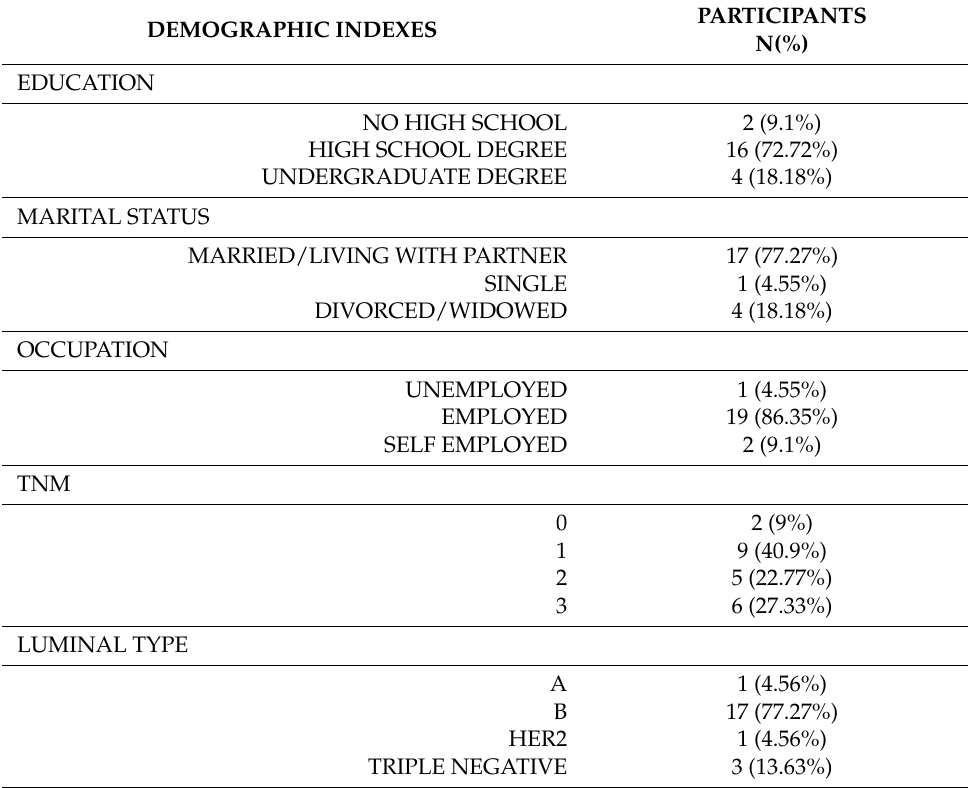
Table 3. Demographic data of participants in Research Protocol